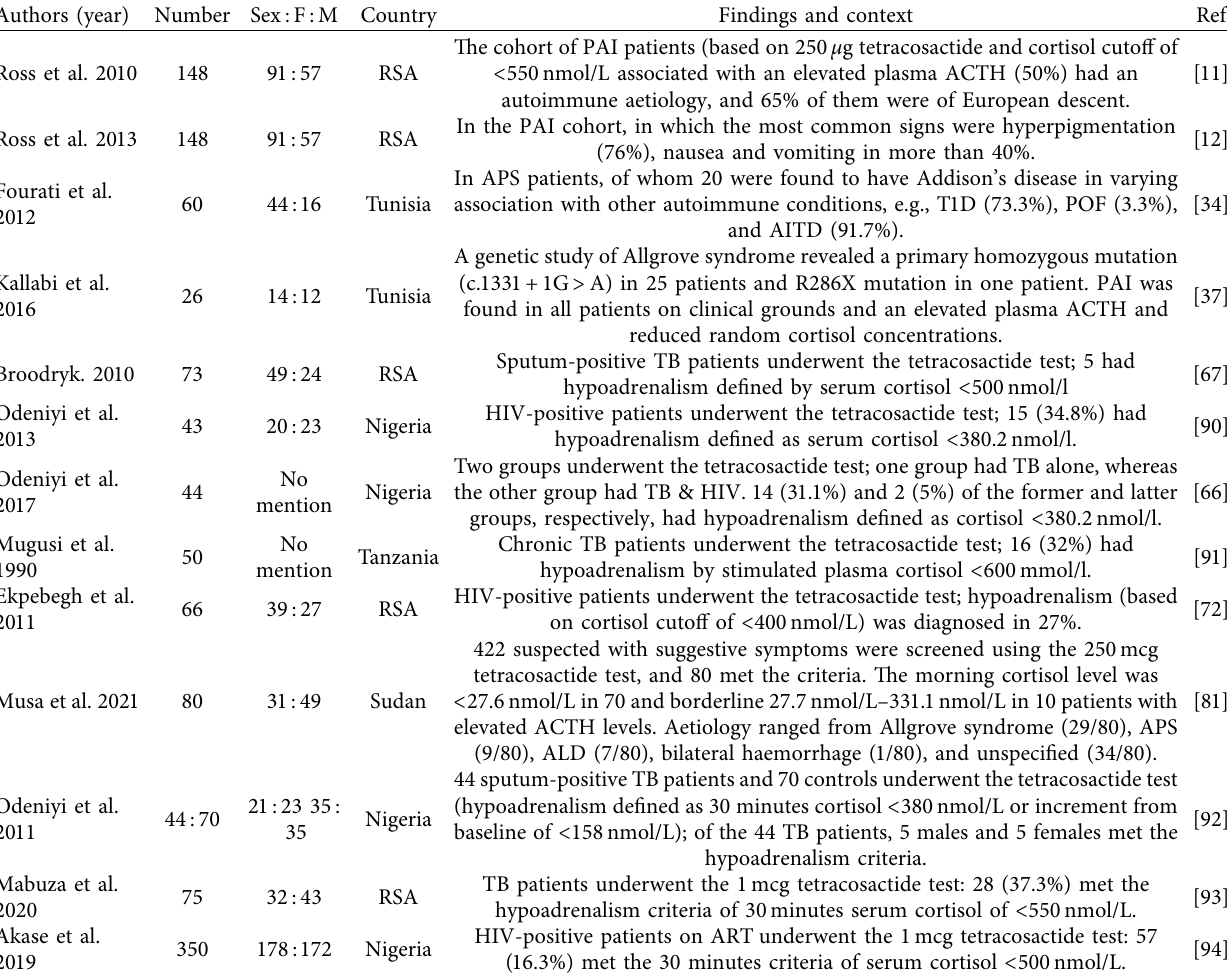
Table 1: Summary of available cohort studies investigating the prevalence and aetiology of primary adrenal insufficiency in Africa under various clinical scenarios.